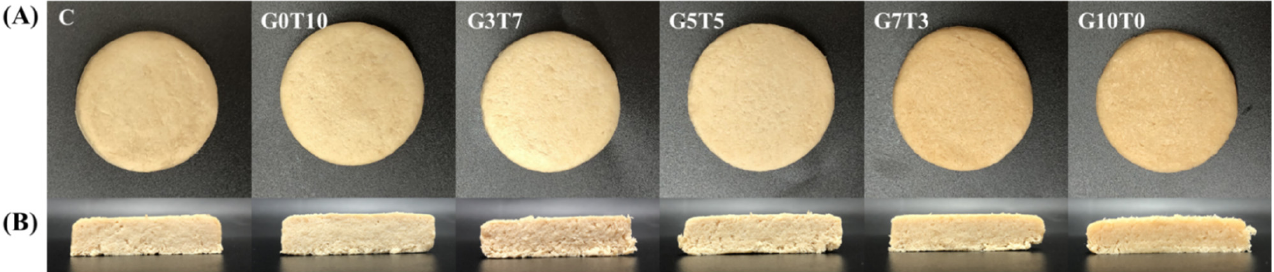
Figure 2. External ( A ) and internal ( B ) appearance of plant-based meat patties (PBMPs) with different binders. C, control; G0T10, GdL:TG = 0:10; G3T7, GdL:TG = 3:7; G5T5, GdL:TG = 5:5; G7T3, GdL:TG = 7:3; G10T0, GdL:TG = 10:0.